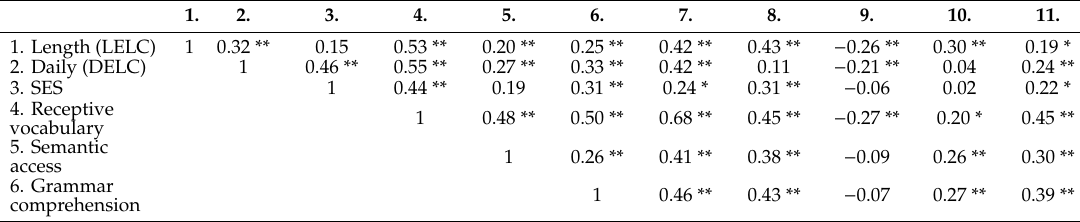
Table 3. Correlation matrix of bilingual exposure, SES and linguistic and cognitive